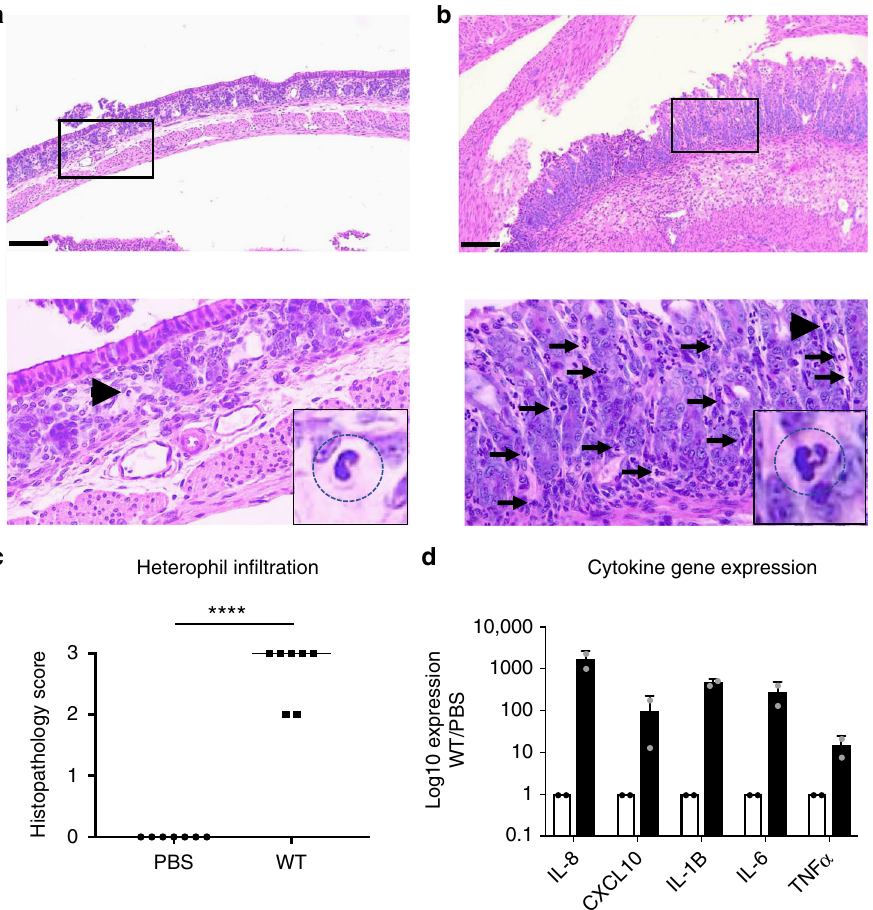
Fig. 2 Pro-in fl ammatory immune responses in the colon of infant rabbits infected with Shigella fl exneri . a , b Representative images of hematoxylin- and eosin-stained colonic sections from animals inoculated with phosphate-buffered saline (PBS) ( a ) or S. fl exneri ( b ). Scale bars, 100 μ m. Top, ×10 images; bottom, ×40 images of the boxed area in top images. Arrows and arrowheads indicate heterophils. Insets, zoom-in on the heterophil indicated by arrowheads. c Graph showing histopathology score of heterophil in fi ltration. Statistical analysis, unpaired Student ’ s t test. Wild-type (WT) vs. mock, **** P < 0.0001. d Chemokine (interleukin-8 (IL-8) and C-X-C motif chemokine 10 (CXCL10)) and cytokine (IL-1 β , IL-6, and tumor necrosis factor- α (TNF α )) gene induction (black bars) in the colon 8 h post inoculation (pi) with S. fl exneri with respect to mock-treated animals (PBS, white bars). Overlay dot plots represent individual data points. Error bars represent standard deviation of the mean. Source data are provided as a Source Data fi